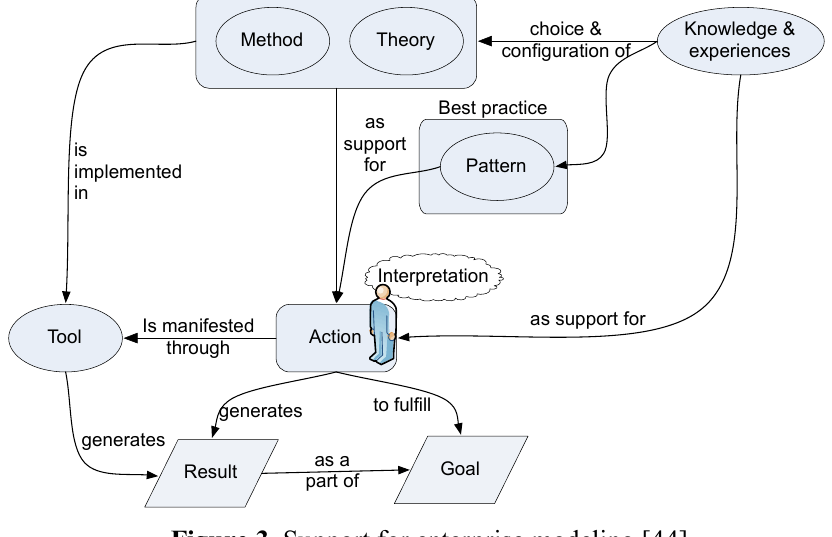
Figure 3. Support for enterprise modeling